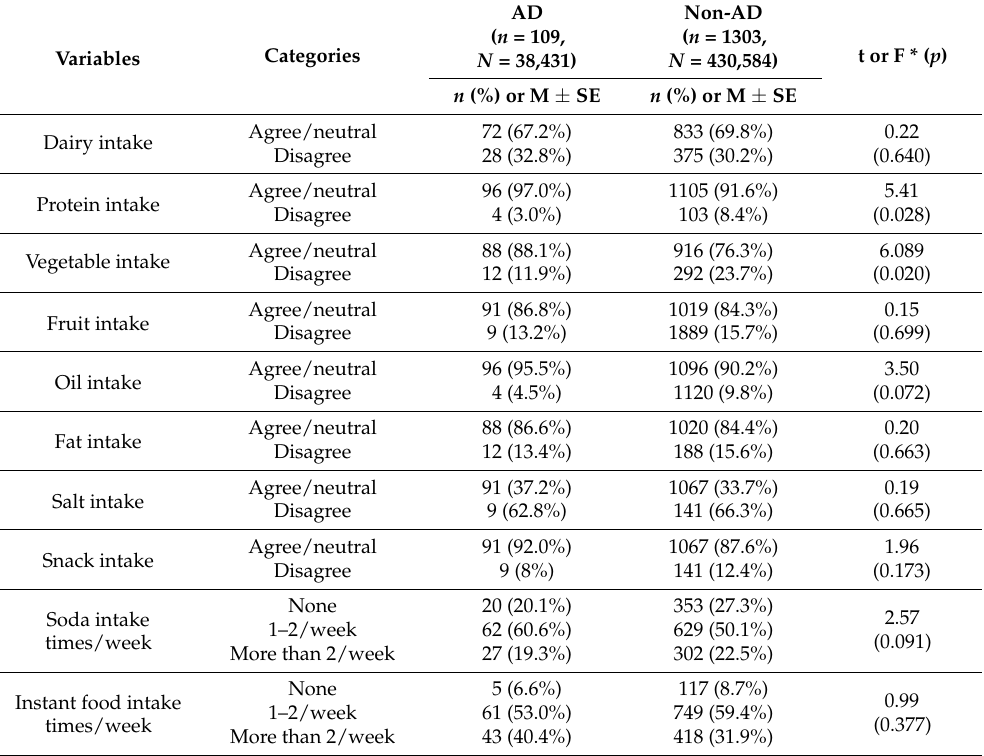
Table 2. Differences in health behavior by history of atopic dermatitis diagnosis ( n = 1412, N =